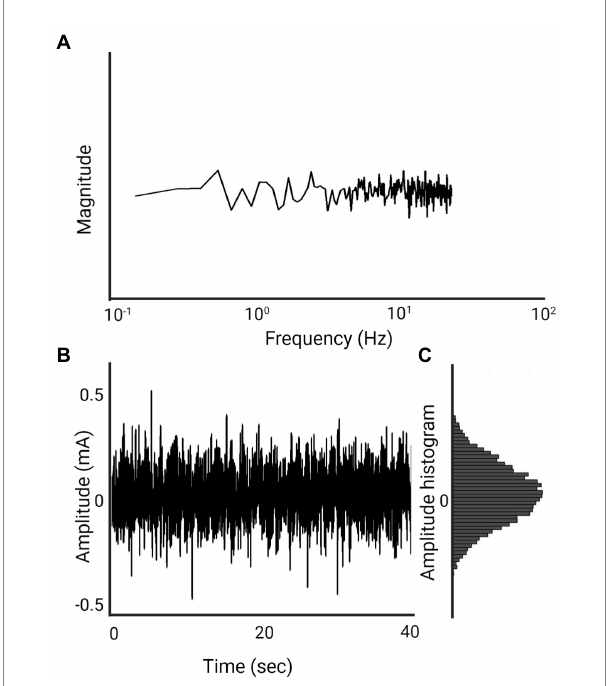
FIGURE 3 1 mA, 0–30 Hz Gaussian white noise nGVS signal (Created with BioRender.com). (A) Spectral frequency graph, the waveform contains frequencies between 0 and 30 Hz with equal intensity at each frequency. (B) Time plot of the signal. The amplitude of 1 mA means that 99% of all generated amplitude values are between 0.5 mA and − 0.5 mA. (C) A histogram of the distribution of the signal amplitude. A random level of current generated for every sample is normally distributed, thus the probability density function follows a bell-shaped curve.